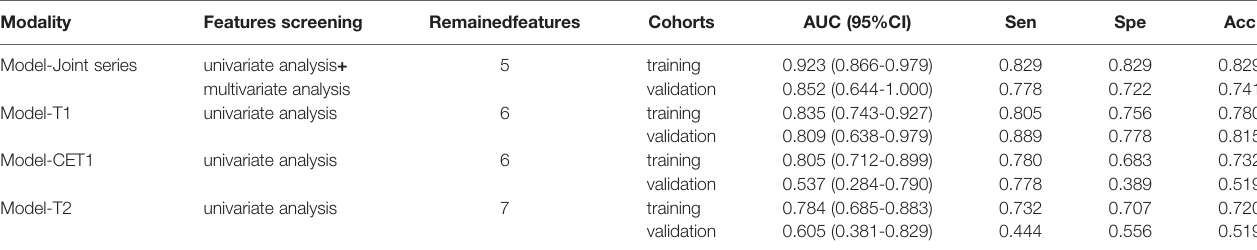
TABLE 2 | The performances of the four logistic regression models in predicting sensitivity to treatment in the training and validation cohorts.